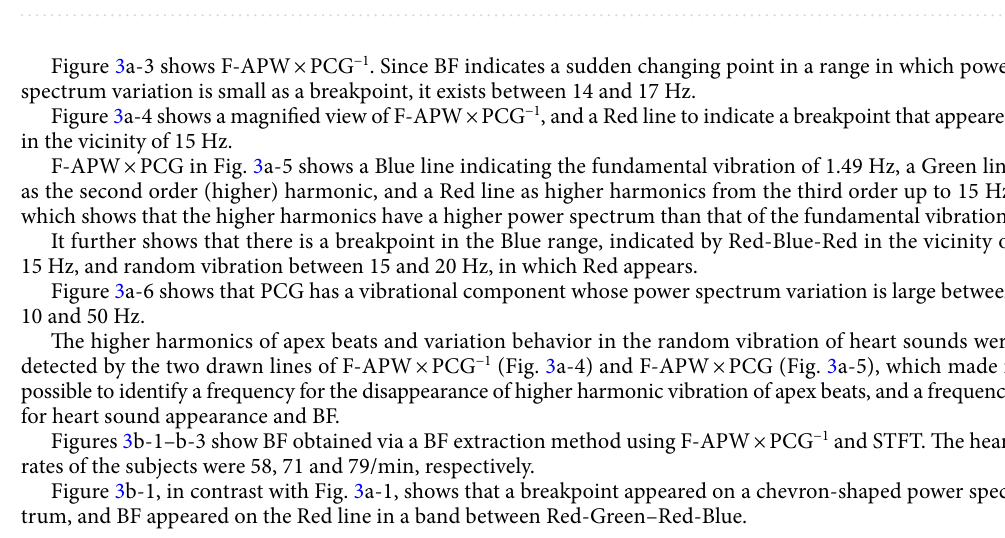
Figure 2. ECG, F-APW and PCG by different heart rates. F-APW measured from the precordial region, ECG and PCG readings of subjects in a sitting position whose mean heart rates for 10 s are 58, 71, 79 and 93/min,